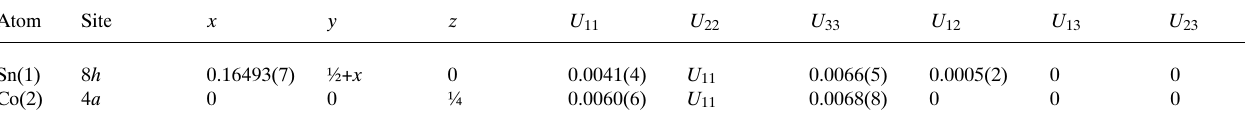
Table 4. Atomic coordinates and displacement parameters (in Å 2 )